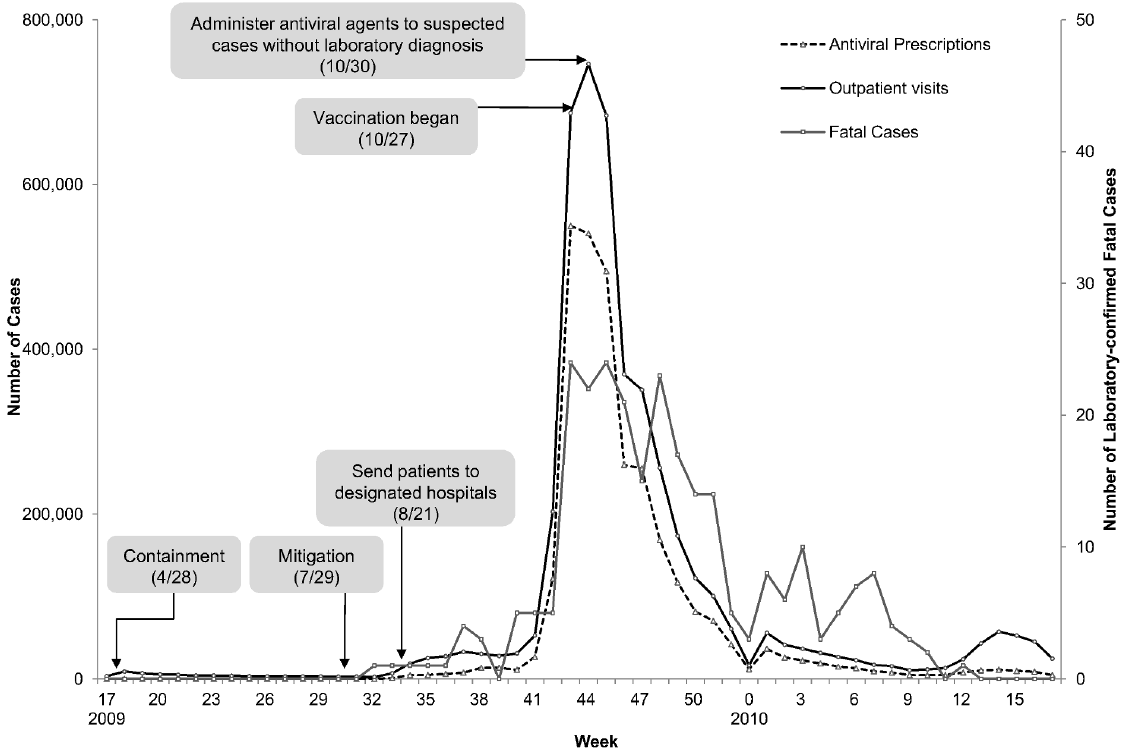
Figure 1. Outbreak of Pandemic Influenza A (H1N1) 2009 and Main Response Strategy in Korea.